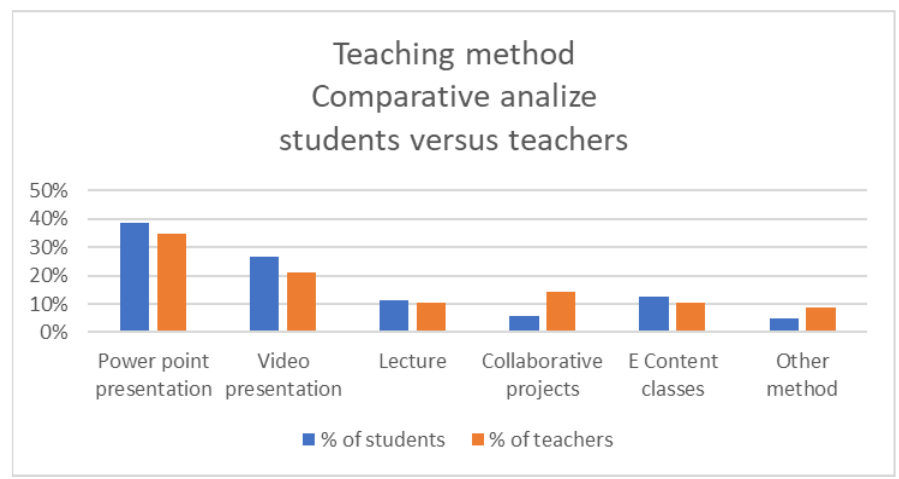
Figure 6. Different perception for teaching method used, teachers versus students.